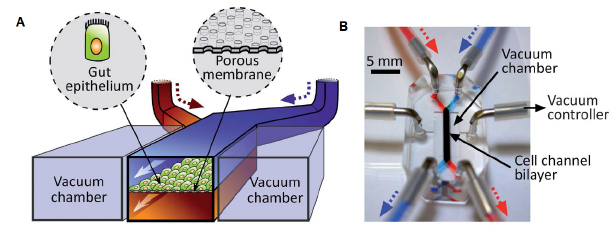
Figure 7. A) Organ on chip device showing an extra cellular matrix (ECM) coated flexible porous membrane with epithelial cells through the middle of the central microchannel and vacuum chambers on both sides; B) Picture of the organ on a chip device (directions indicated by arrows visualize perfusion of the red and blue dyes). Copied with permission